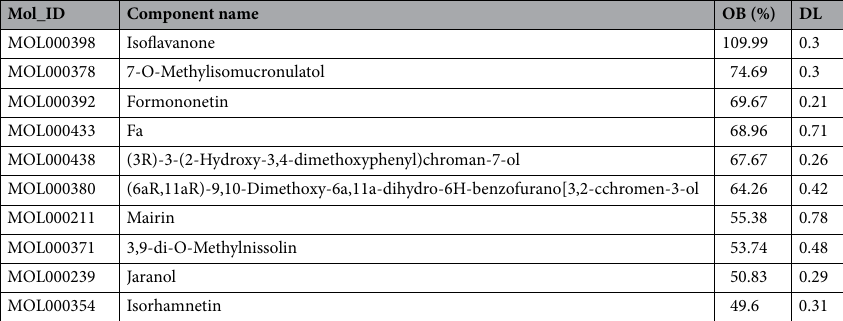
Table 1. Components of AM-AS compound (top 10 of OB